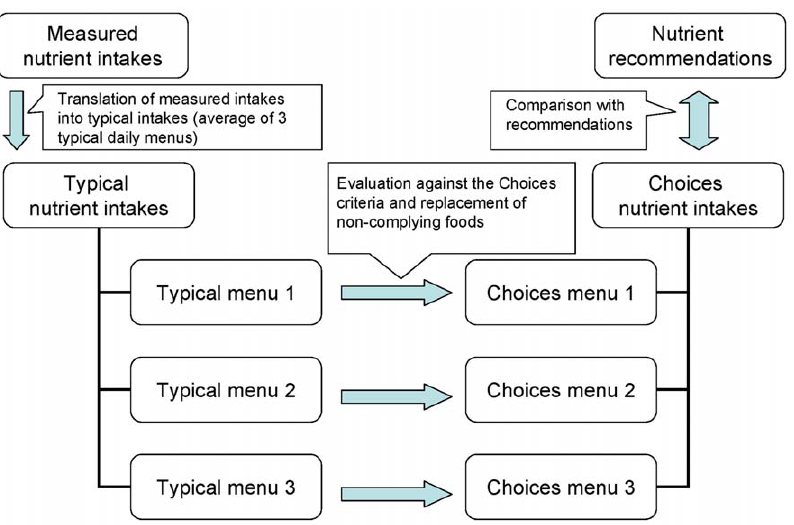
Figure 1. Description of Daily Menu Method. Average intakes of energy SAFA, TFA, sodium, sugar and fibre were derived from dietary intake studies and food consumption surveys. These average intakes were translated into three Typical Daily Menus per country. Average intakes based on these three menus were compared with average intakes from three Choices Daily Menus. To compose the Choices Menus, foods from the Typical Menus that were not complying with the Choices criteria were replaced with foods that did comply and are available on the